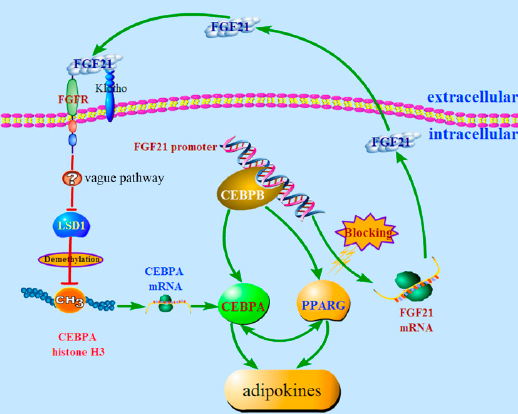
Figure 8. The proposed mechanism of FGF21 action in triglyceride metabolism. Briefly, FGF21 suppressed adipogenesis by reducing LSD1 expression, and in the meantime, FGF21 expression was repressed by the transcription factor CEBPB . The red line represented for the action of inhibition and the green line represented for the action of activation.